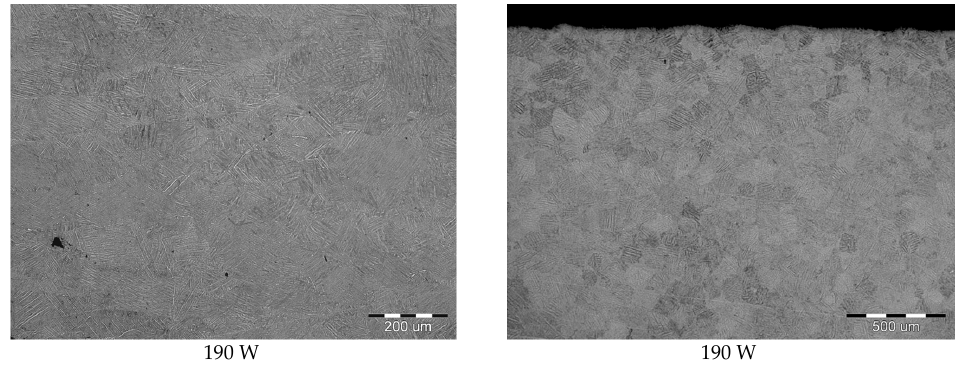
Figure 8. Microstructure of annealed materials, mag. 500×, LM.